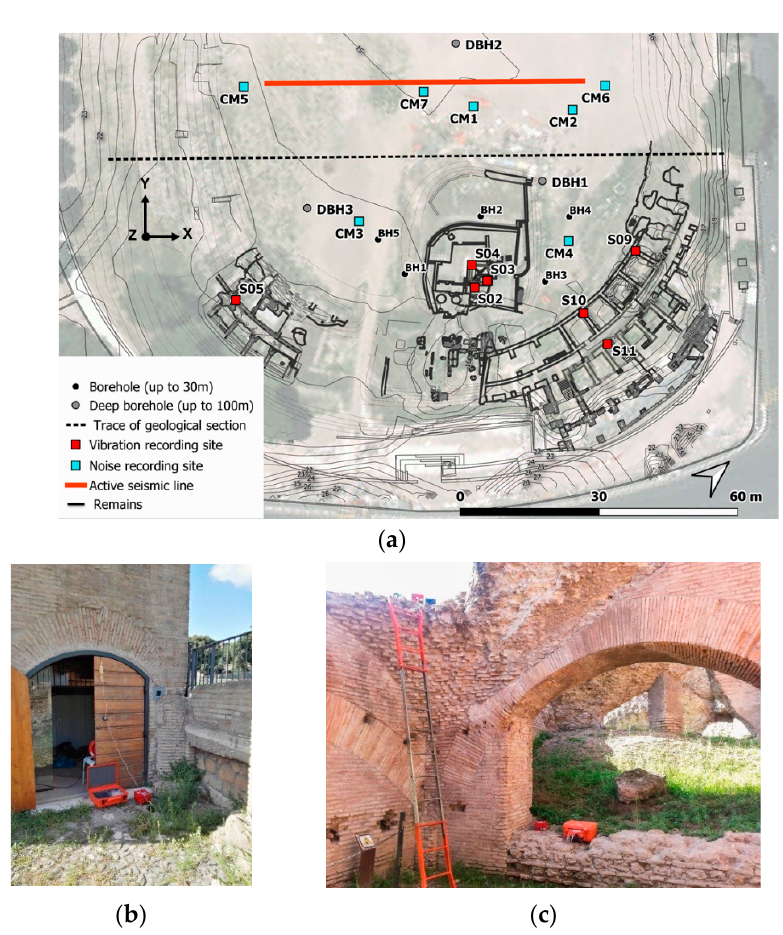
Figure 4. ( a ) Sensor deployment, ( b ) Sensors S02 and ( c ) S10 ( top left ) and S11 ( bottom ). For each location, the y direction was parallel to the major axis of the Circus, the x direction was orthogonal to it, and the z direction was the vertical